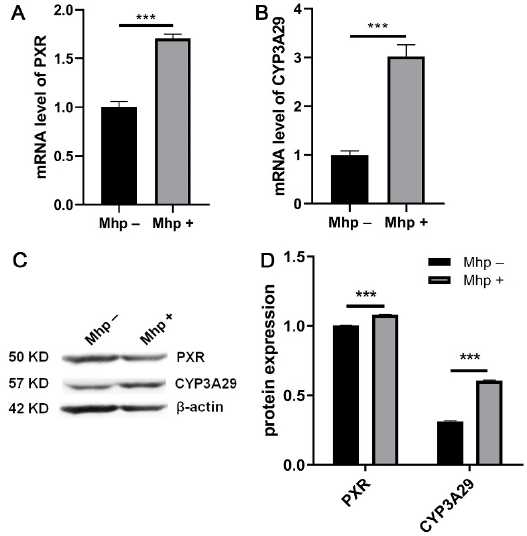
Figure 2. Changes in PXR and CYP3A29 protein and mRNA expression levels after M. hyopneumoniae infection. The mRNA expression levels of ( A ) PXR and ( B ) CYP3A29 after M. hyopneumoniae infection of PAM 3D4/21 cells for 24 h. ( C ) The protein expression of PXR and CYP3A29 after M. hyopneumoniae infection. ( D ) Analysis of the relative protein expression based on the gray values of the bands in panel C. The data are presented as the mean ± SD. The experiment was repeated three independent times. *** p < 0.001 compared to the uninfected